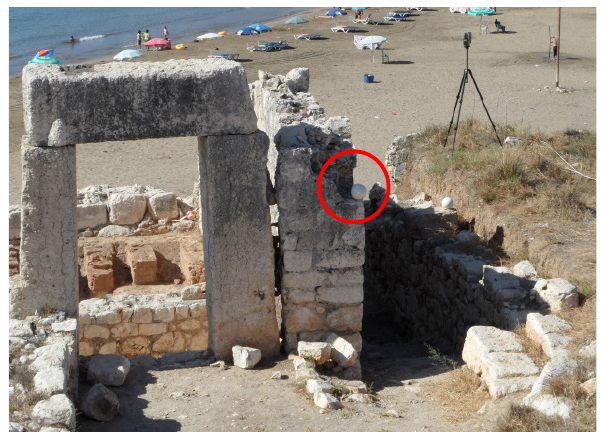
Figure 8. Spherical target.